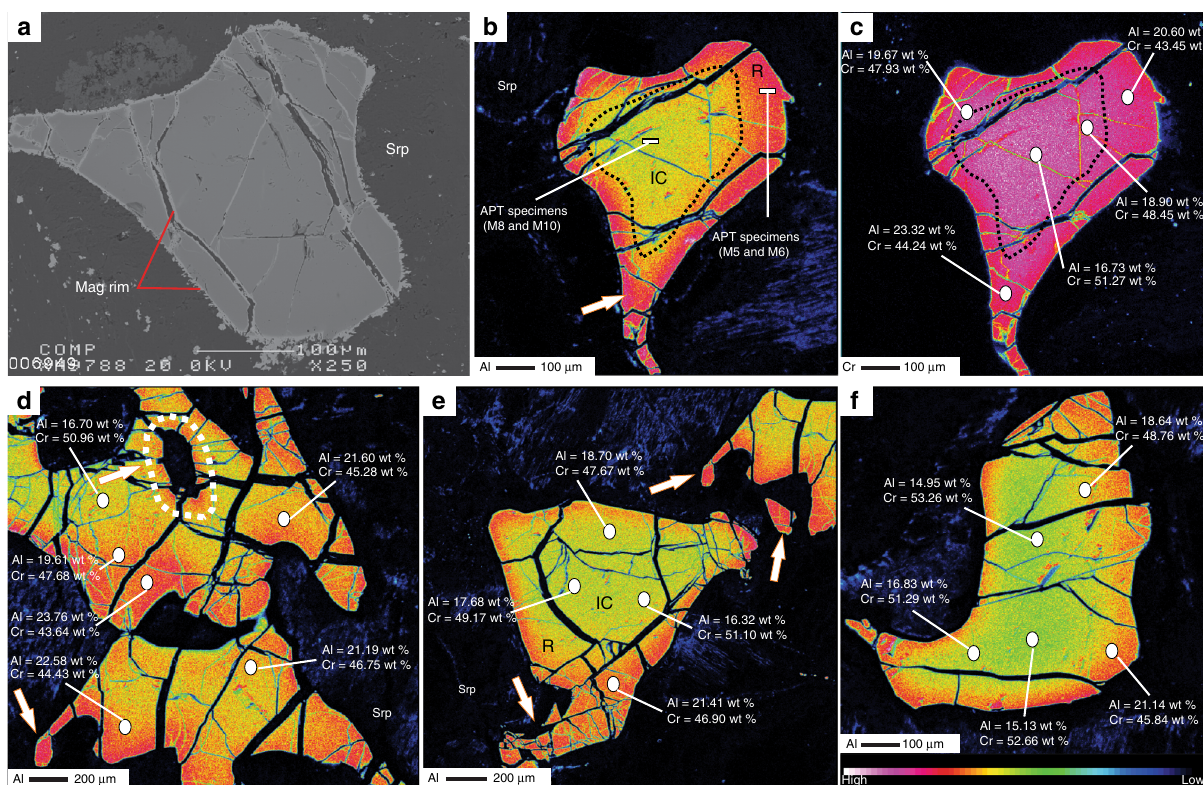
Fig. 1 X-ray elemental map of the studied Cr-Spinel. a Backscattered electron (BSE) image of a Cr-spinel grain with a homogenous core surrounded by a small magnetite rim. Al ( b ) and Cr ( c ) X-ray map for the same grain show reverse zoning for Al and Cr. Asymmetrical and heterogeneous distribution of Al-Cr within the core ( d ) and gradual increase of Al-Cr from core to rim ( b , c , e , f ) of three different Cr-spinel grains. White arrows point to Al halos around inclusions within the Cr-spinel grains ( d ) and high Al content in small grains with tightly curved rims ( b – e ). The results of the Atom probe tomography (APT) specimens for the core (M8 and M10) and rim (M5 and M6) are shown in Fig. 5. Mag = magnetite, Srp = serpentine, IC = inner core andR =